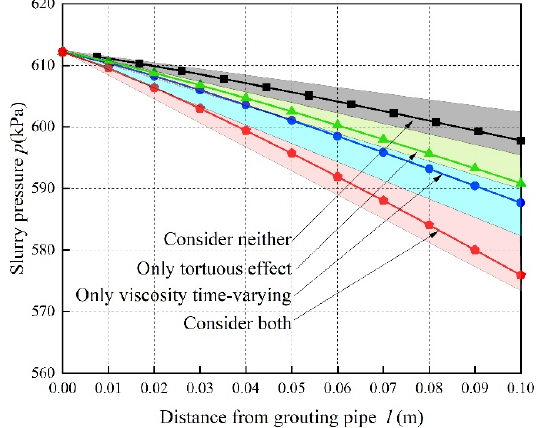
Figure 7. Attenuation law of slurry